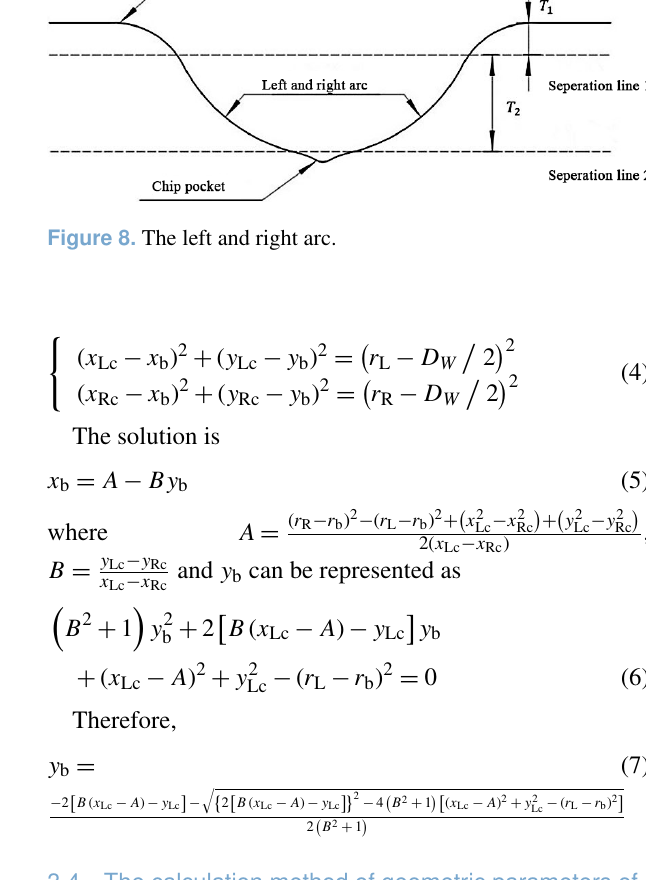
Figure 7. The process of determining the starting point.